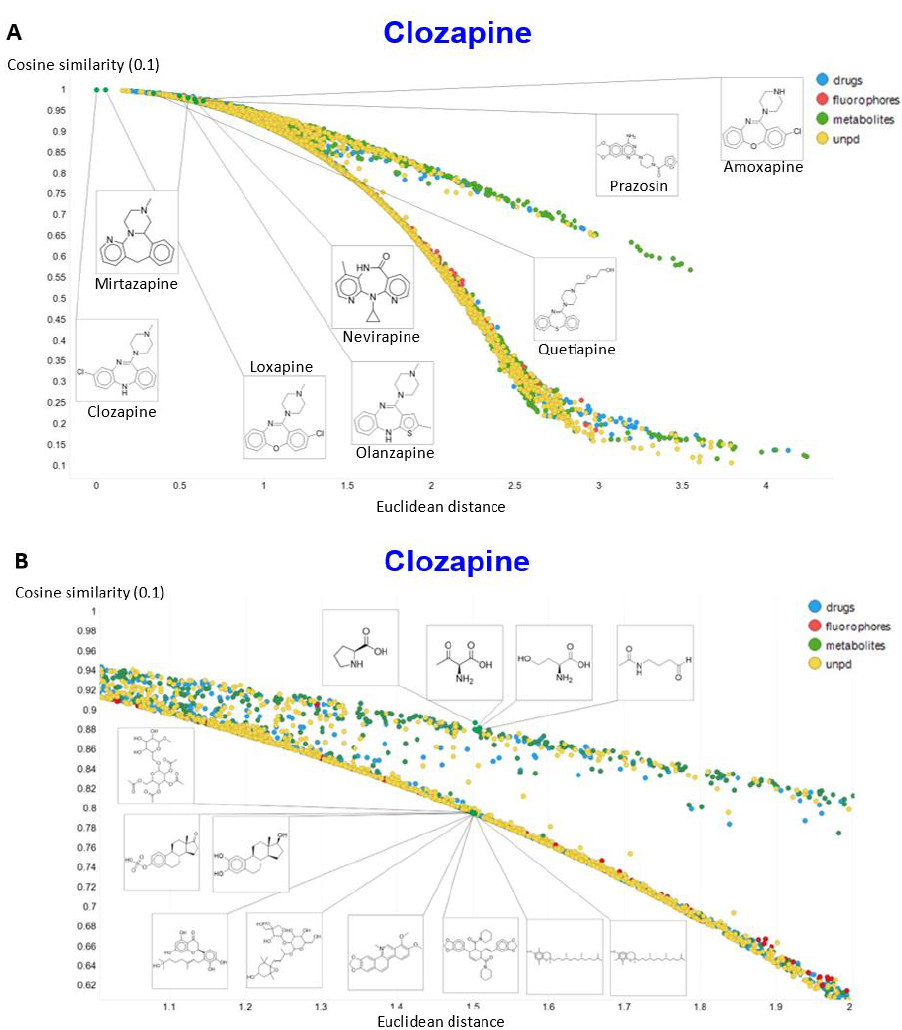
Figure 10. Relationship between cosine similarity and Euclidean distance for clozapine in our chemical space using a temperature of 0.1. ( A ) Overview. ( B ) Illustration of molecules in the bifurcation.